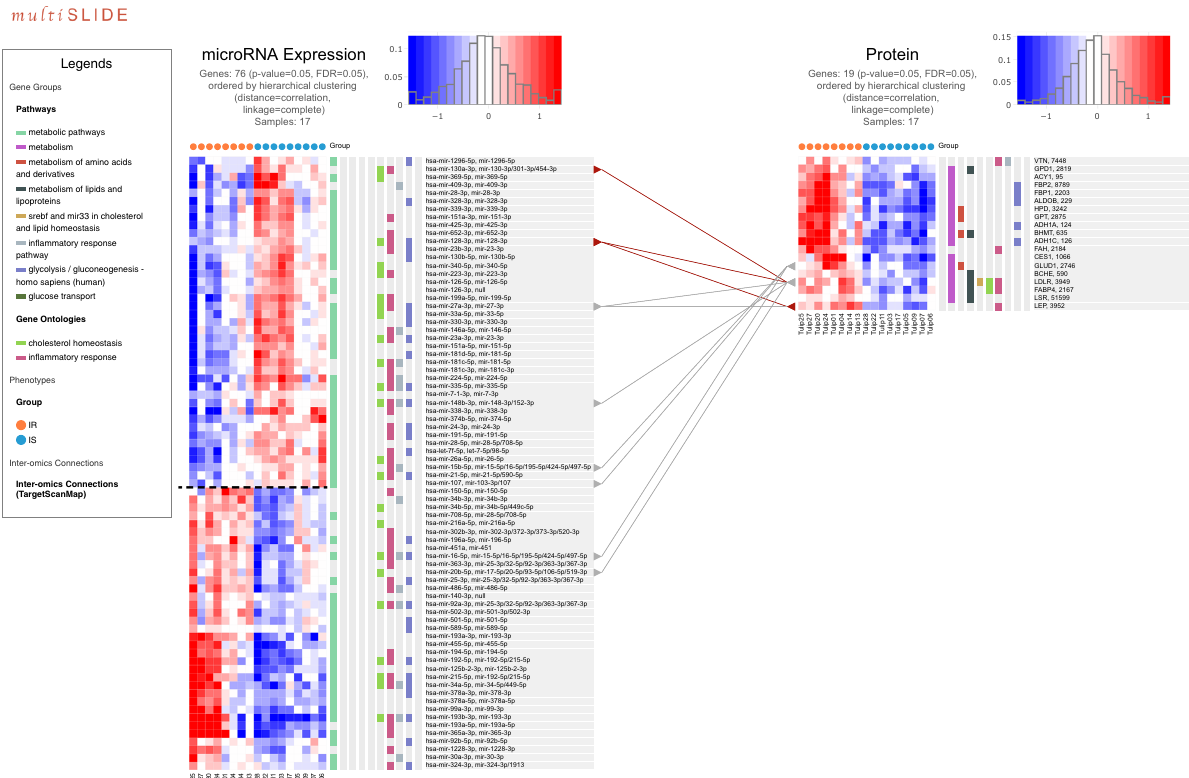
Fig. 4 Visualization of plasma proteins and microRNAs associated with insulin resistance. Shown in the heatmap are the molecules matched by the keywords: metabolism, in fl ammatory response, glucose transport, and lipid homeostasis are visualized here after fi ltering by Mann – Whitney U -test ( p value ≤ 0.05 followed by FDR 5%). Proteins and miRNA are independently clustered using correlation distance (1 minus Pearson correlation) and complete linkage function. The relationships between miRNA family names and their target proteins are extracted from TargetScanMap 50 . The original list of 414 proteins and 69 miRNAs, before fi ltering, is shown in Supplementary Fig.